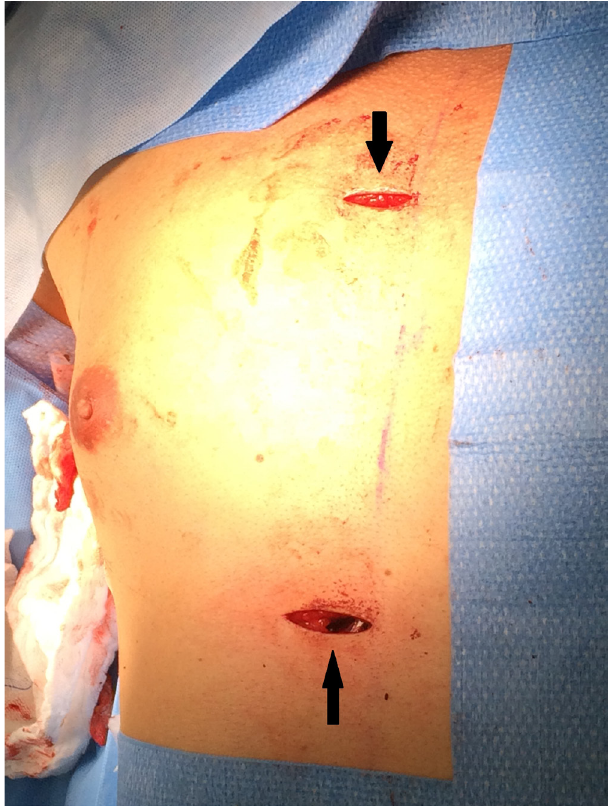
Fig. 2 - The picture is showing the left lateral thorax view. The arrow is pointing out the first